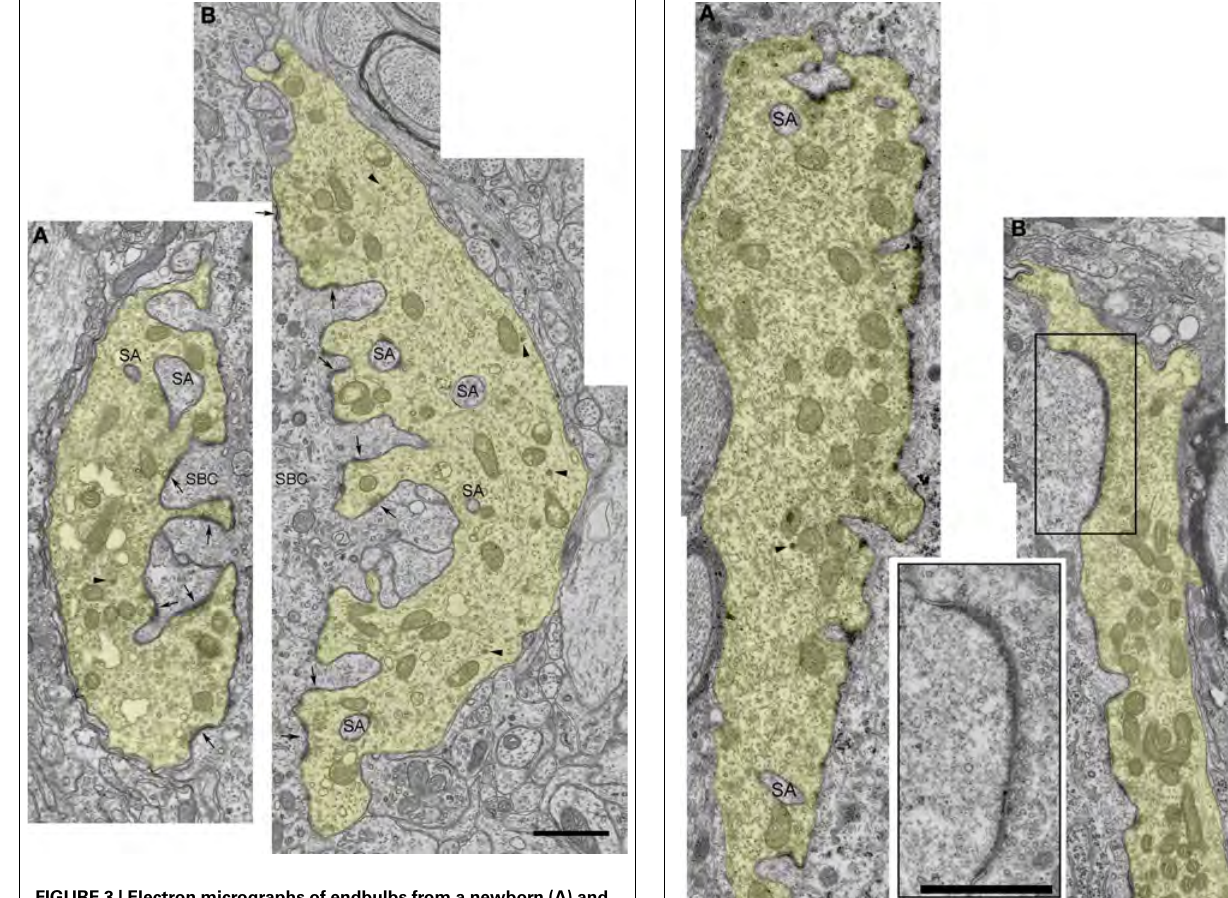
FIGURE 3 | Electron micrographs of endbulbs from a newborn (A) and 5-day old (B) deaf white kitten. (A) The endbulb (yellow) exhibits highly irregular surface contact with the spherical bushy cell (SBC) and contains somatic appendages (SA). Symmetric membrane thickenings mark puncta adherentia; asymmetric membrane thickenings and accumulations of synaptic vesicles mark PSDs (arrows). This newborn white kitten exhibited normal cochlear morphology but was produced by a breeding tom and queen that only give rise to deaf offspring; it had about half the normal number of PSDs in comparison to pigmented kittens, and its PSDs were about 50% longer than those of newborn pigmented animals. Large dense-core vesicles can be found away from active zones (arrowheads). (B) Electron micrograph of 5-day-old endbulb. This kitten exhibited cochlear pathology and its endbulb morphology was similar to that of a newborn white kitten. Scale bar equals 1 µm.